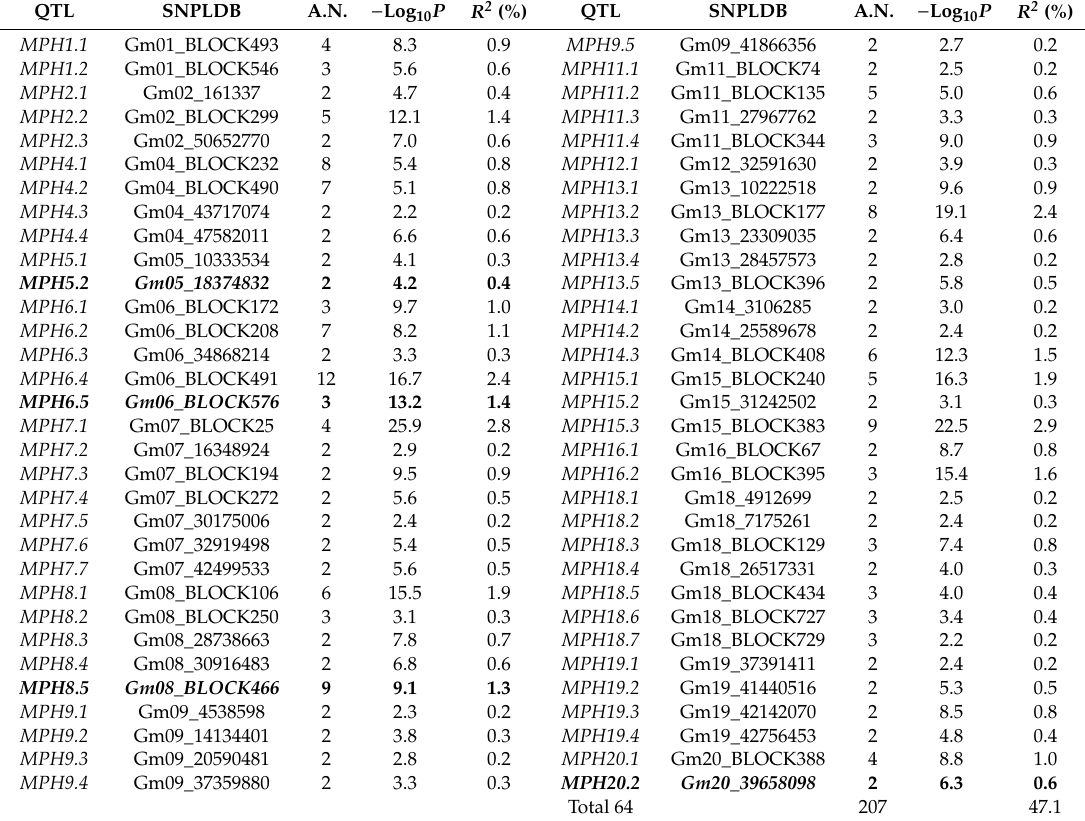
Table 3. The QTL conferring drought tolerance in terms of MPH in CCSP.